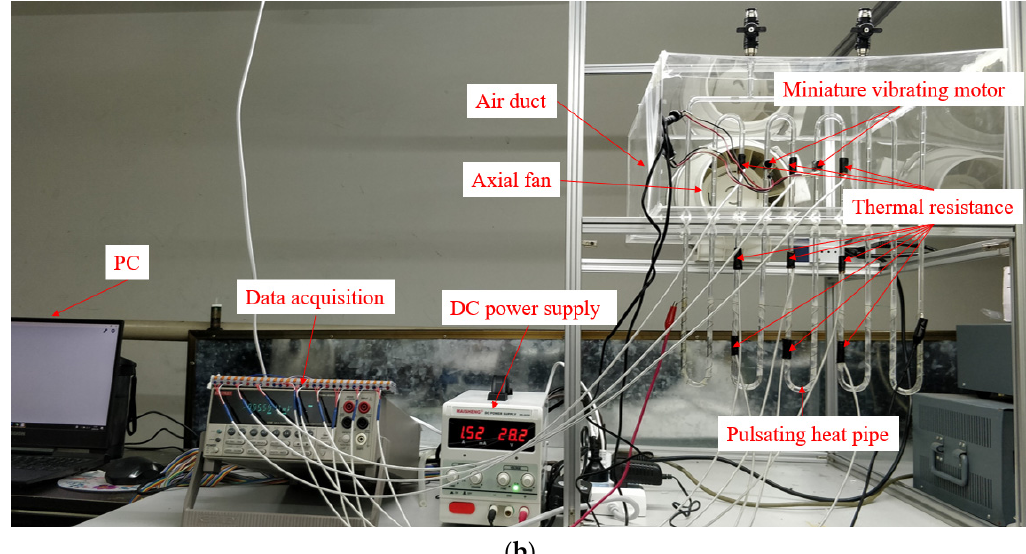
Figure 2. Experimental setup: ( a ) diagrammatic sketch; ( b ) photo (in order to show the heating mode and thermal resistance position, the heating part was not wrapped with thermal insulation film when shooting).